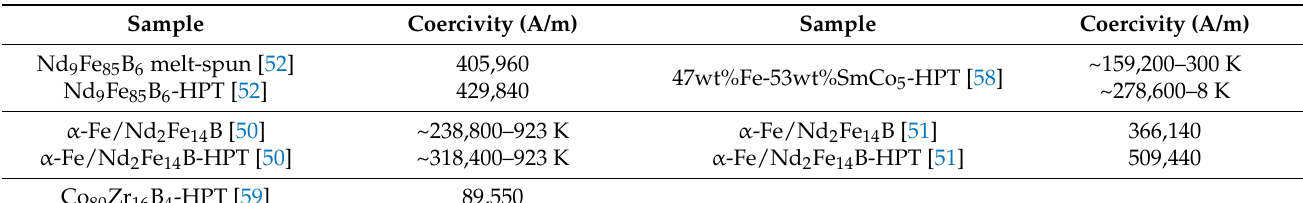
Table 2. The coercivity of the selected ternary magnetic alloys before and/or after